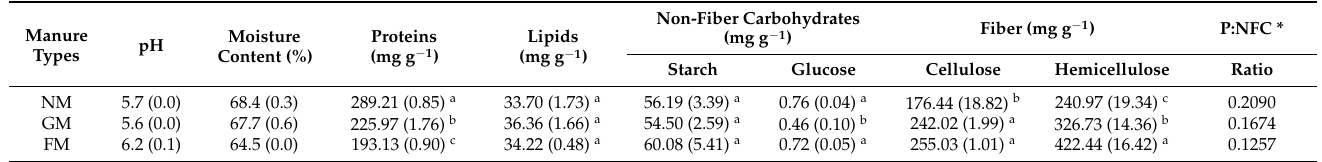
Table 1. Nutrient composition of different fattening pig manure types.